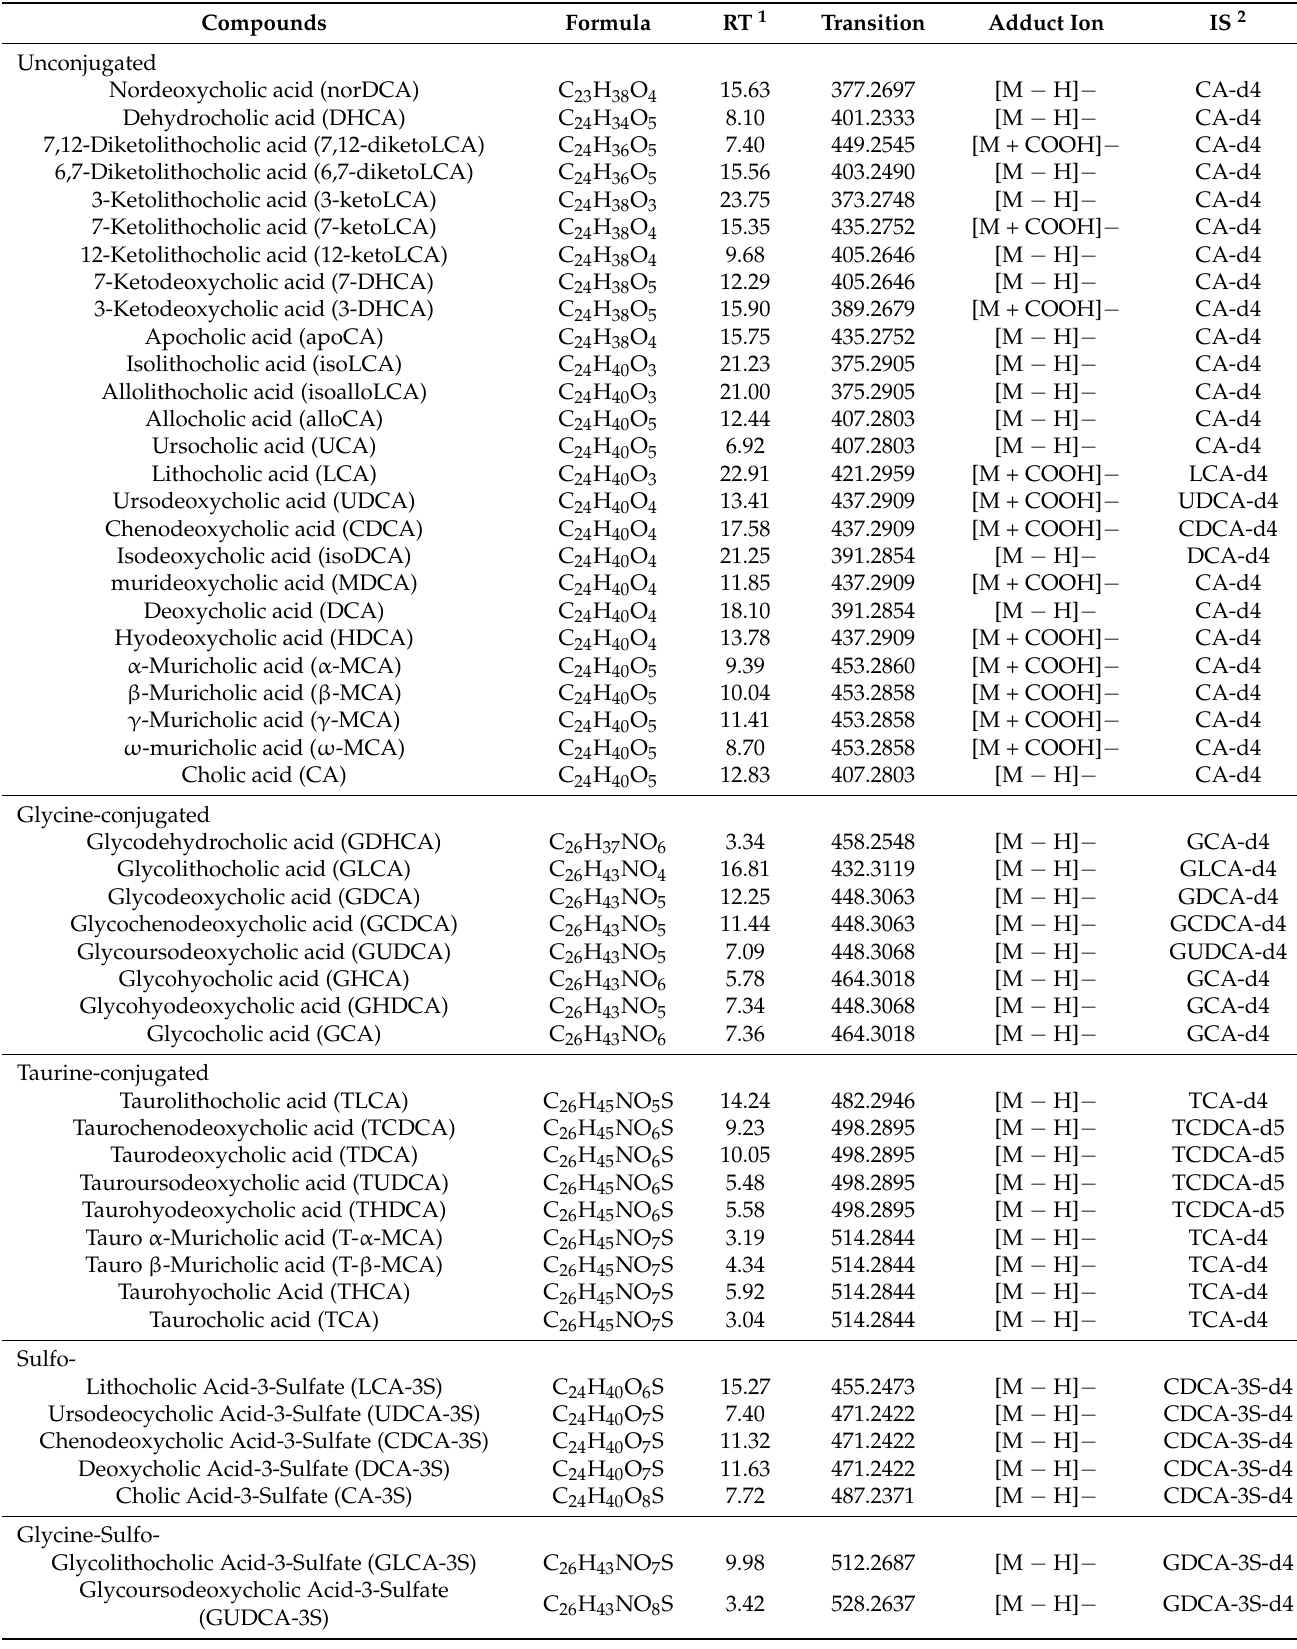
Table 1. Bile acid analyte structural, quantitative, and qualitative information.